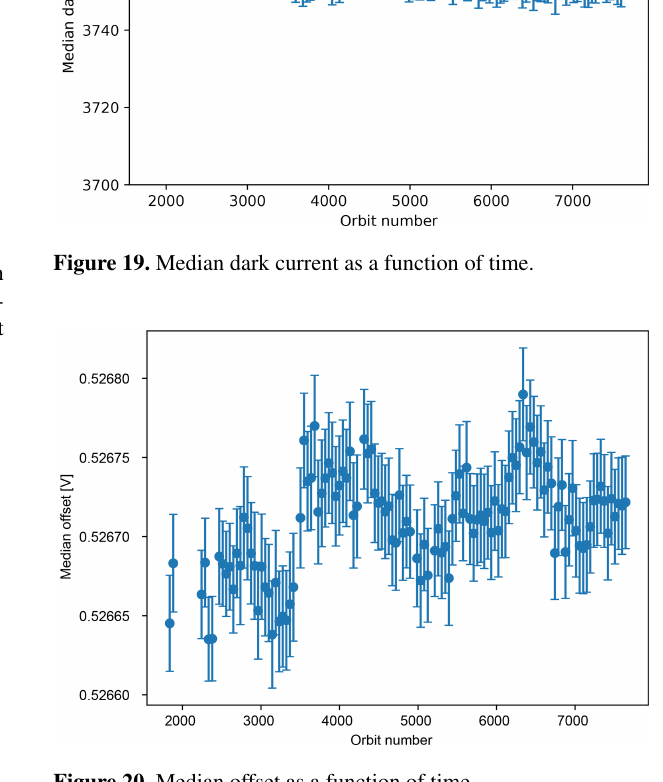
Figure 20. Median offset as a function of